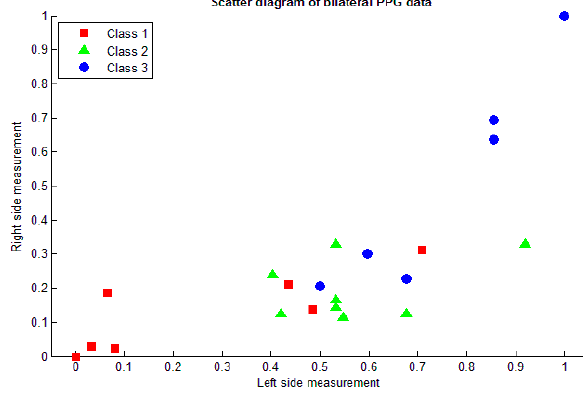
Figure 6. Scattered plot of bilateral PPG feature.